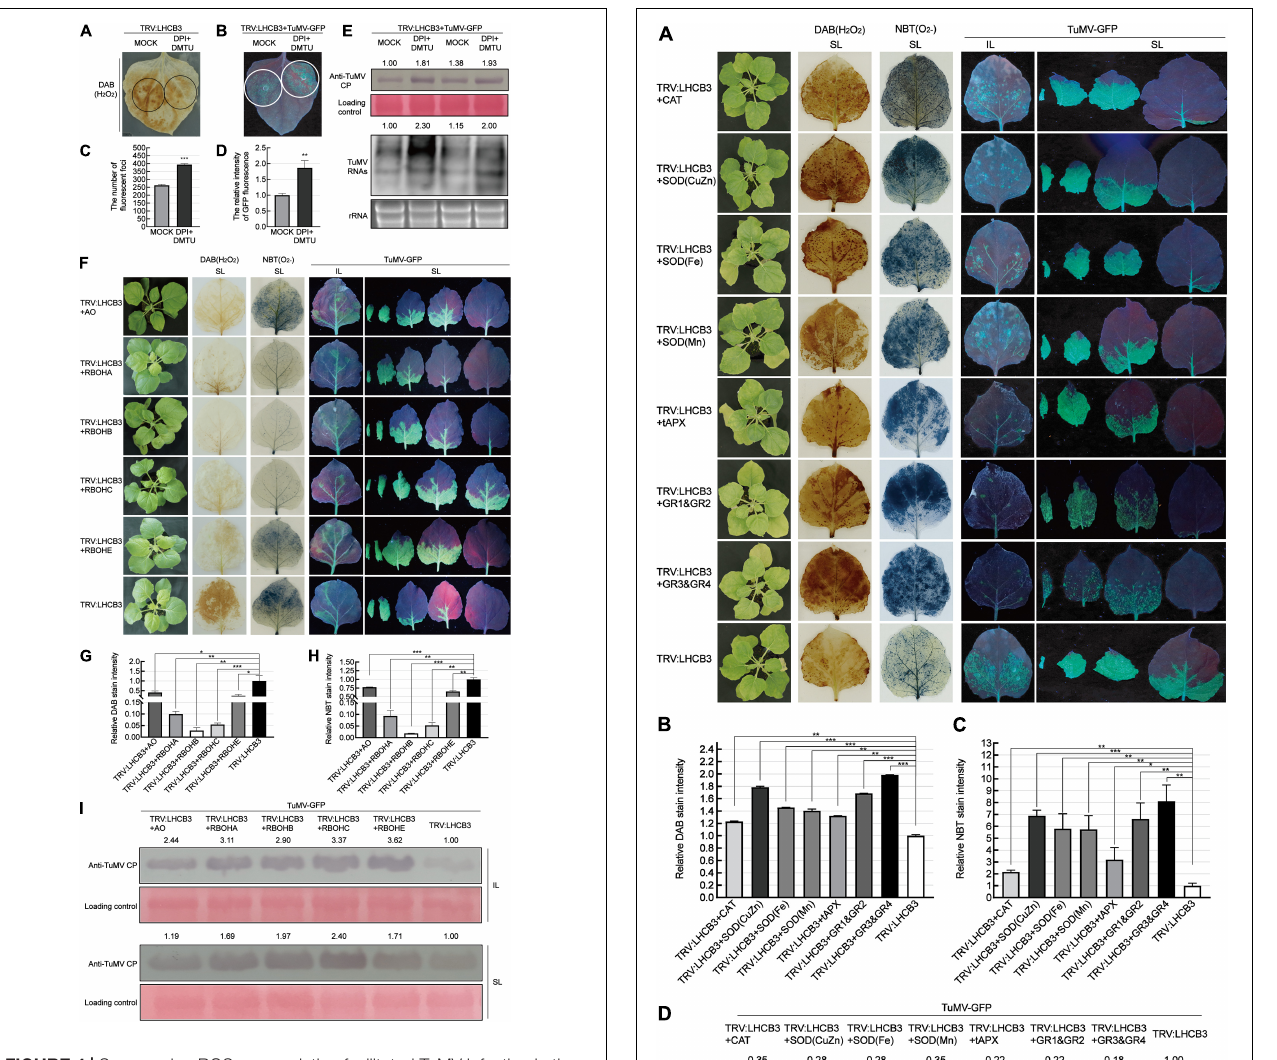
FIGURE 4 | Suppressing ROS accumulation facilitated TuMV infection in the NbLHCB3 -silenced plants. (A) DAB staining of ROS accumulation in the TRV:LHCB3 plants after being treated with DPI and DMTU. Treated zones are circled in black. (B) Treatment of DPI and DMTU facilitated TuMV-GFP infection in the NbLHCB3 -silenced plants. Treated zones are circled in white. GFP fluorescence is shown under UV light at 4 dpi. (C) The number of fluorescent foci in the zones of NbLHCB3 -silenced leaves treated or not with chemical inhibitors of ROS. (D) The relative intensity of GFP fluorescence in the zones of NbLHCB3 -silenced leaves treated or not with chemical inhibitors of ROS. (E) Accumulation of TuMV CP protein and RNAs in the TRV:LHCB3 plants treated with DPI or DMTU. (F) TuMV-GFP infection in plants where NbLHCB3 was co-silencing with different genes in the ROS production pathway. The phenotype of plants under bright light is shown at the left. DAB staining and NBT staining show ROS accumulation in the silenced plants. TuMV-GFP infection in the inoculated leaves (IL) and systemically infected leaves (SL) was monitored under UV light at 5 dpi. SL at the corresponding location in plants were collected for analysis. (G) The relative DAB stain intensity calculated by IMAGE J software. (H) The relative NBT stain intensity calculated by IMAGE J software. (I) Western blotting showing the accumulation of TuMV-GFP CP in the plants at 5 dpi. The relative intensity of the blot signal was quantified by IMAGE J software. Bars represent the standard errors of the means from three biological repeats. A two-sample unequal variance directional Student’s t -test was used to test the significance of the differences (* P < 0.05; ** P < 0.01; *** P < 0.001).